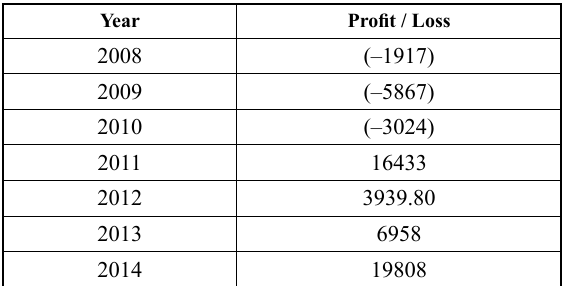
Table 2. Profit/loss of Sia Baa Rīga, per year, EUR